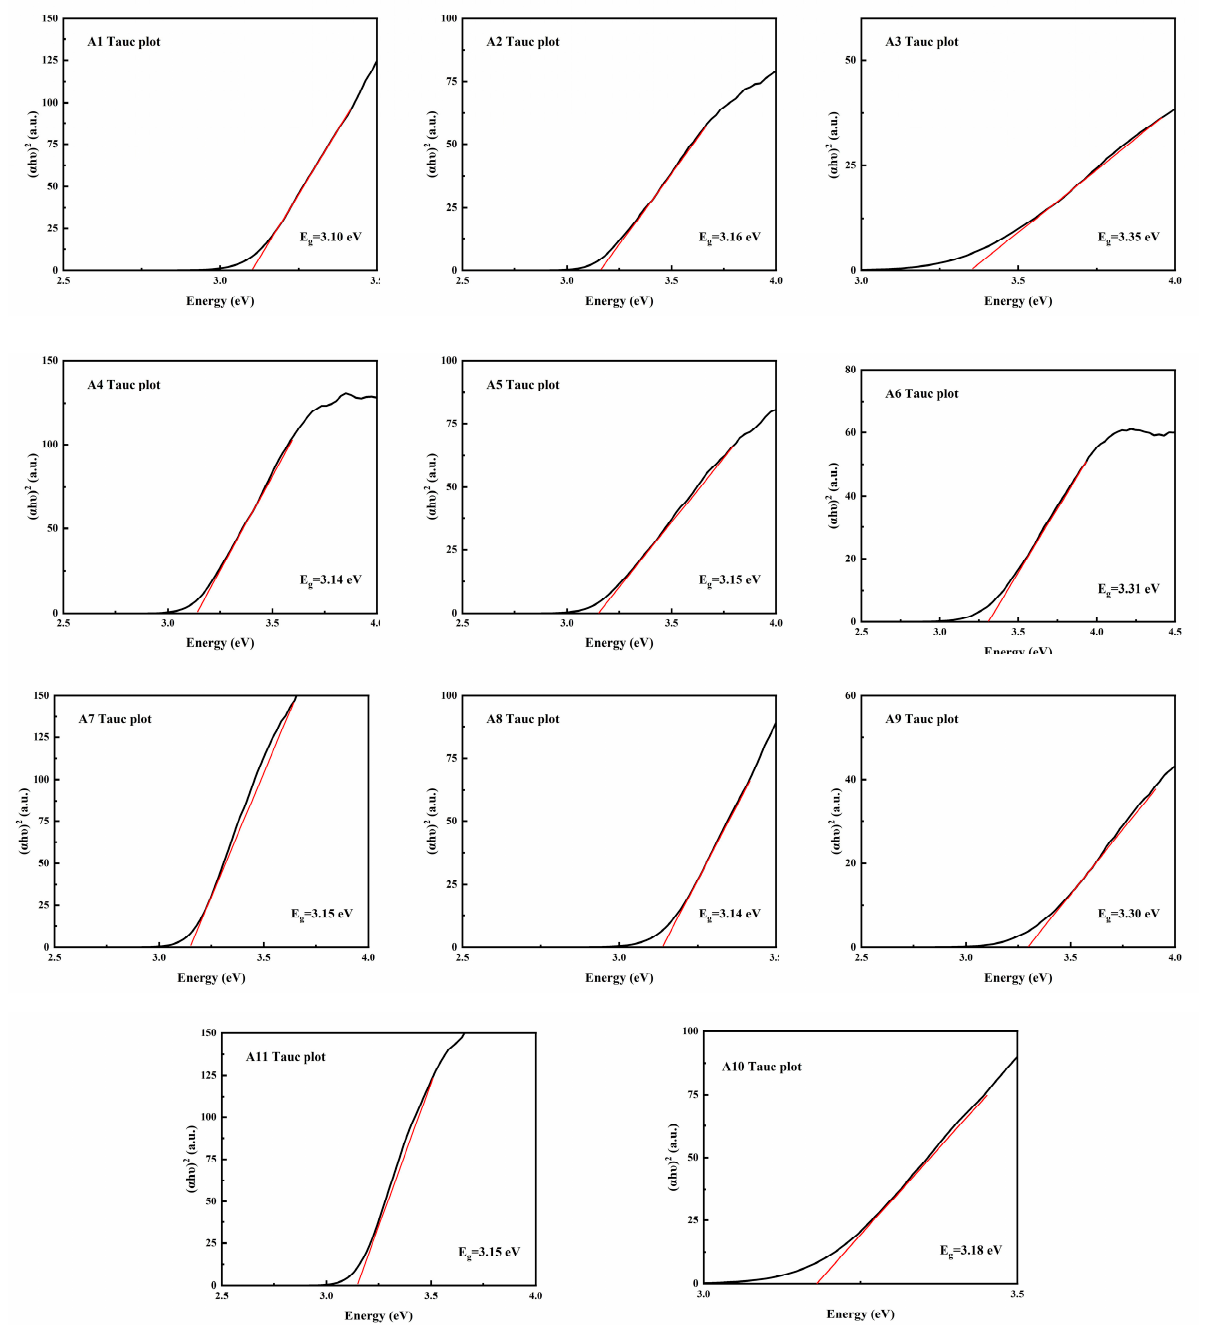
Figure 8. Band gap calculation using Kubelka–Munk (K–M) function of samples A1–A11.